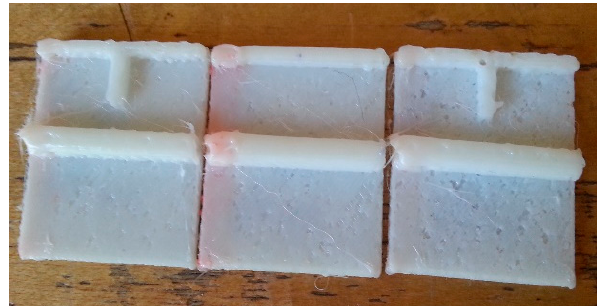
Figure 2. Test samples produced with fused deposition modeling (FDM) using travel speeds of the extruder (left to right) of 15, 20, and 30 mm/s.